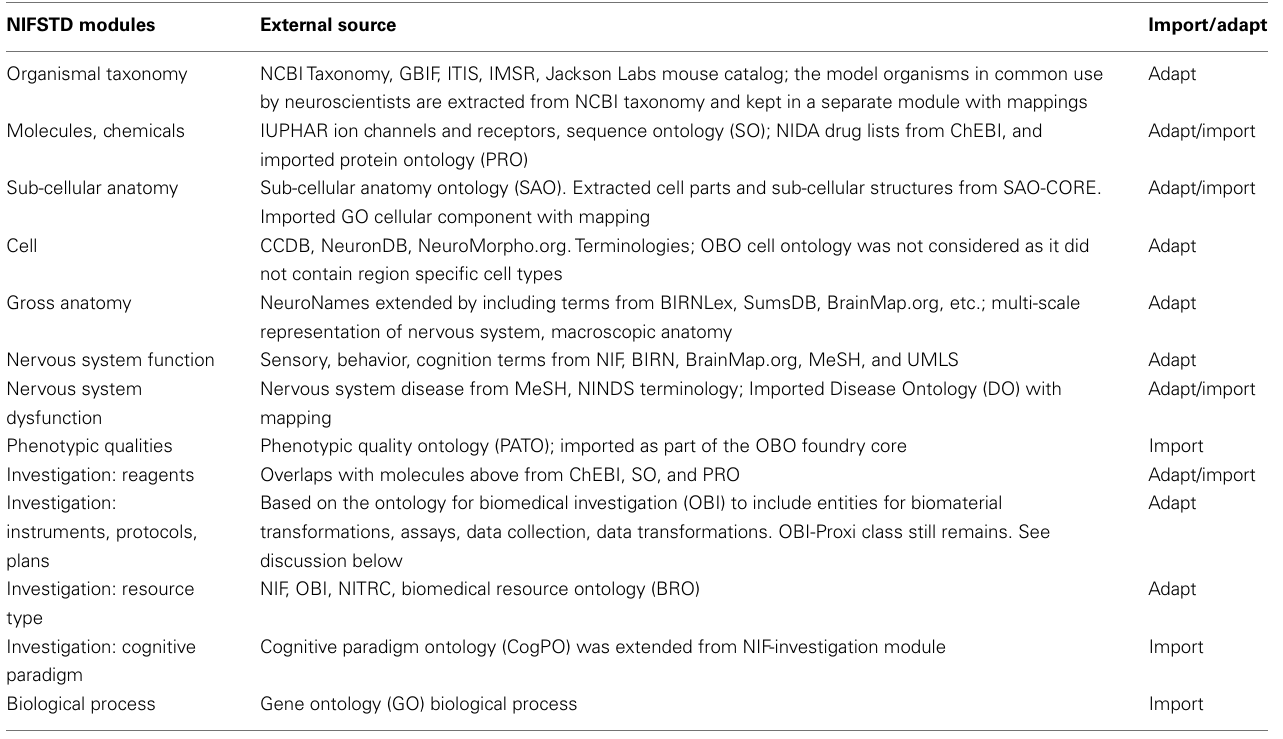
Table 1 |The NIFSTD OWL modules and corresponding community sources from which they were built. NIFSTD